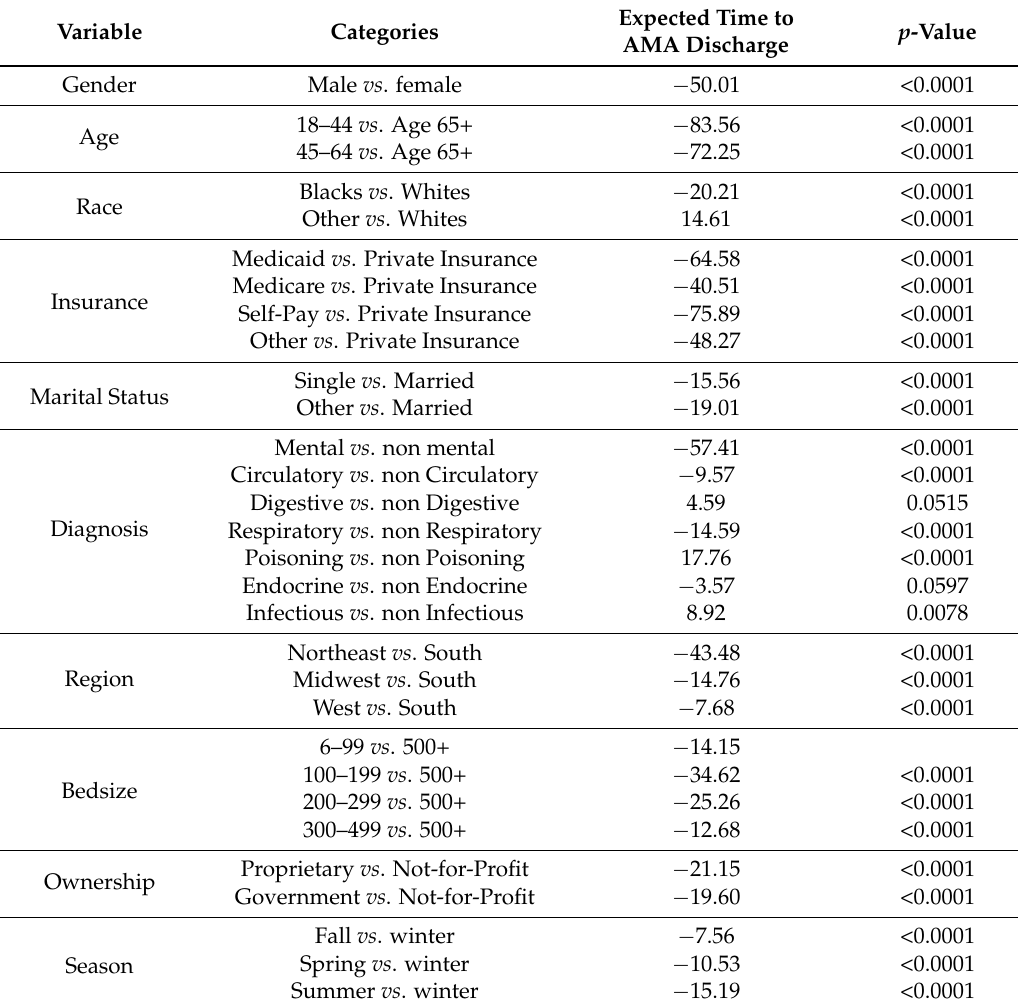
Table 3. Adjusted associations of patient and hospital characteristics with the expected time to AMA